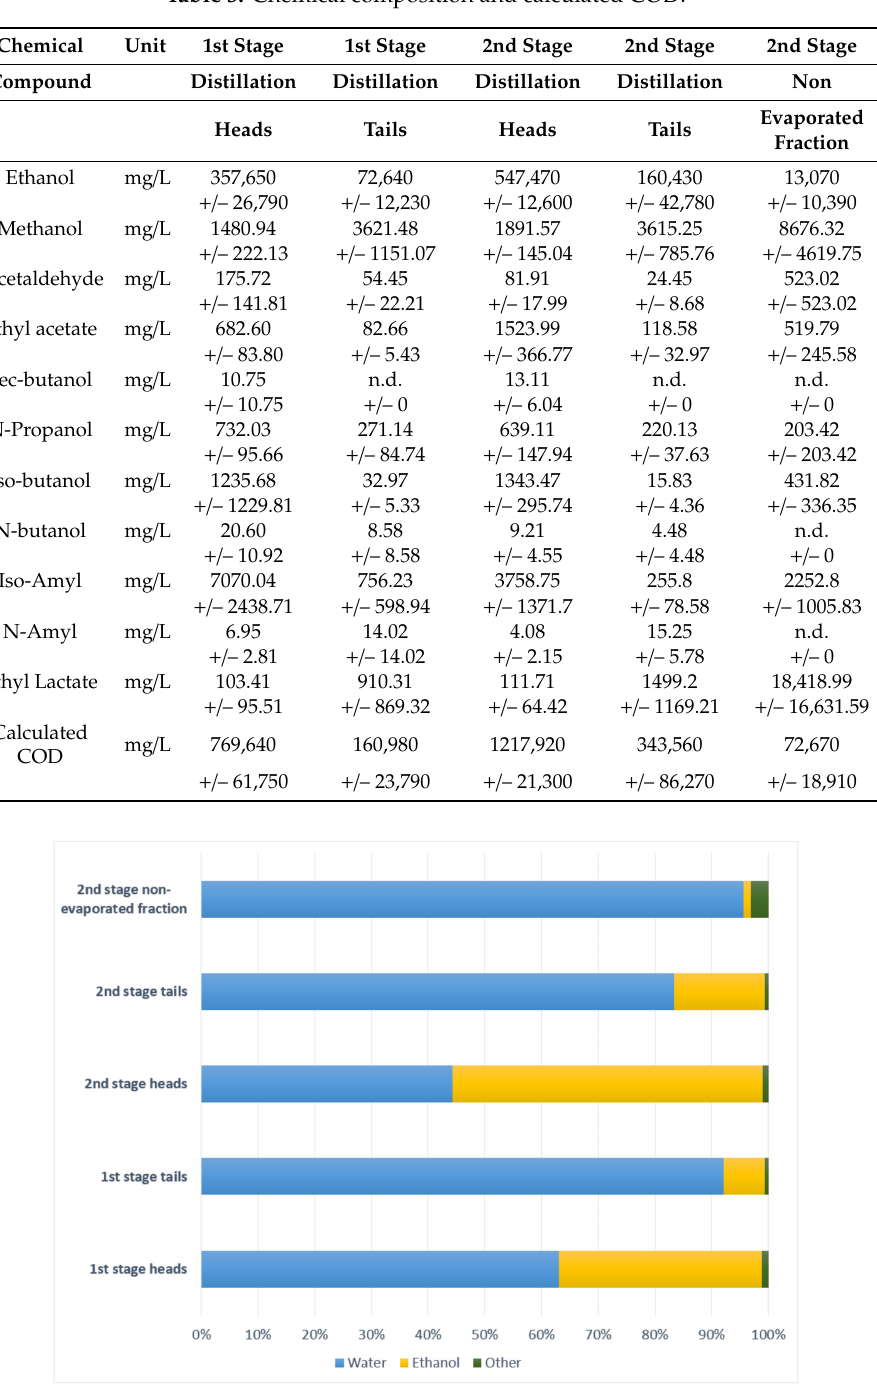
Figure 3. Chemical composition: mean mass proportion of major